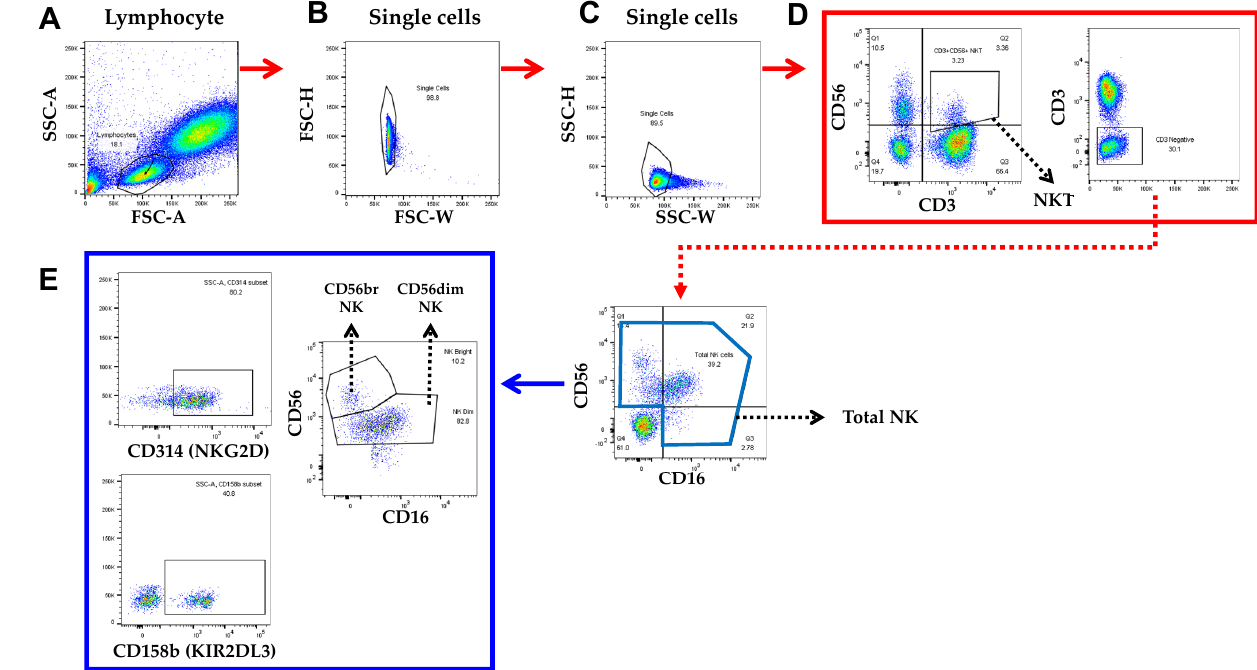
Figure 2. Flow cytometry analysis of NK cells in an ovarian cancer-removed survivor. A front scattered light (FSC)-A and side scattered light (SSC)-A plot were used to identify nucleated cells. ( A ) A lymphocyte gate was set based on the size and granularity of the cells. ( B ) Single cells were gated, and doublets were excluded. ( C ) CD14+ macrophages were excluded. ( D ) NK cells were defined as CD3 − CD56+. ( E ) Two NK cell subsets were identified: CD16+ and CD16 − NK cells. NKG2D and KIR2DL3 were defined as CD314 and CD158b, respectively. Subpopulations of human peripheral blood cells were analyzed as follows. Blood 50 µ L was stained with anti-human antibodies against anti-human CD3-Fluorescein isothio- cyanate (FITC; Cat No. 555339), CD56-Phycoerythrin (PE; Cat No. 555516), Human NKG2D/CD 314 Antibody (Cat No. MAB139-SP), and KIR2DL3/CD158b (Cat No. MAB2014-SP) from